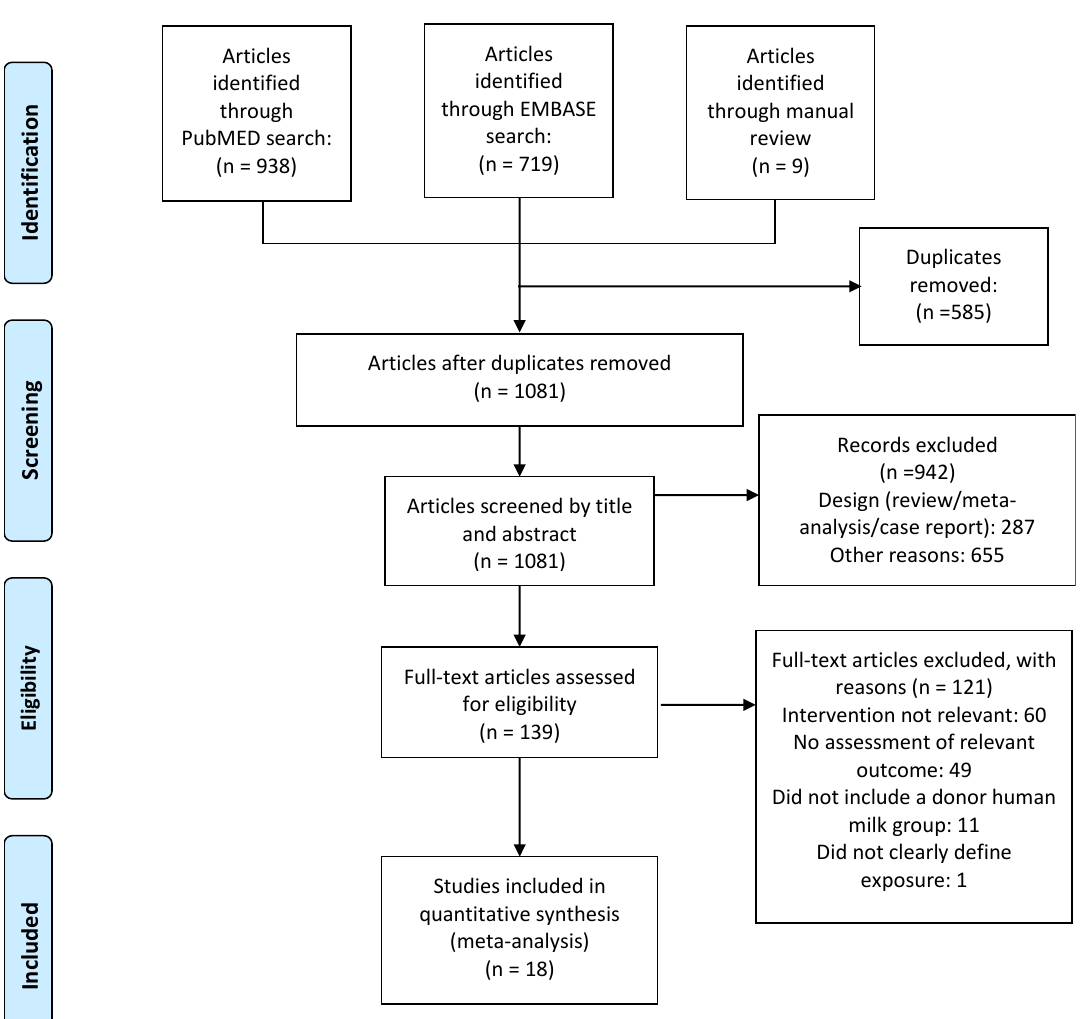
Figure 1. Flow diagram of the literature search process.